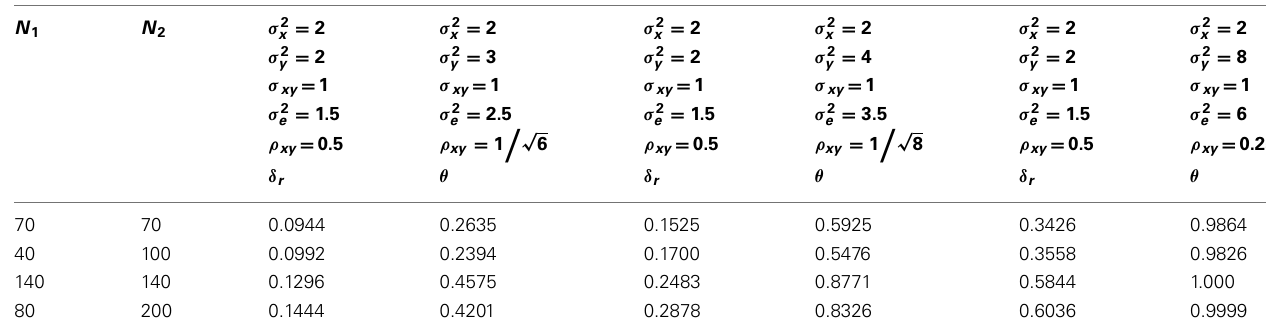
Table 3 | Power: unmoderated slopes and moderated